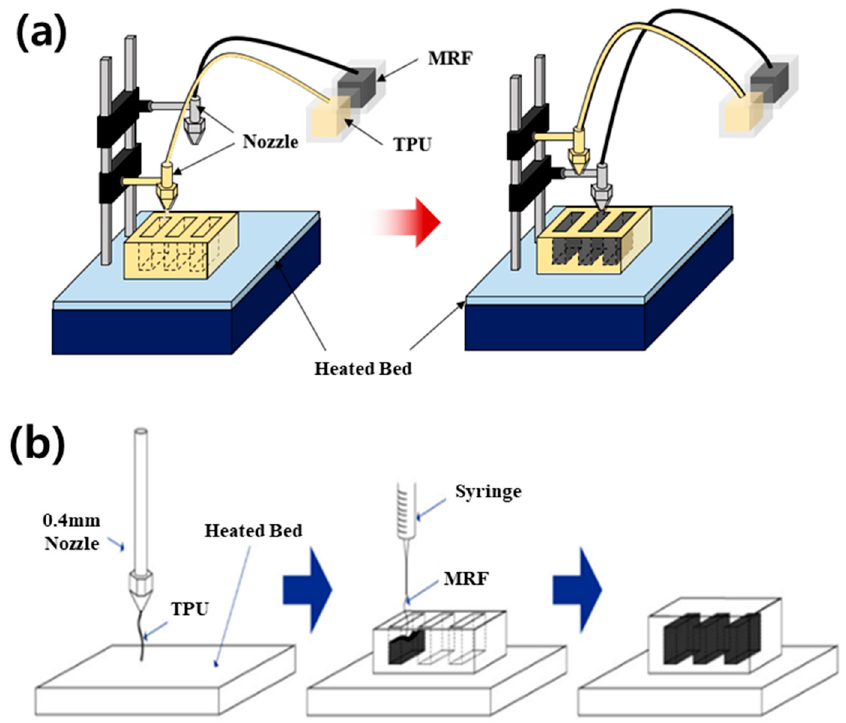
Figure 3. Three-dimensional printing of the soft structure: schematics of the ( a ) equipment and ( b ) manufacturing process.